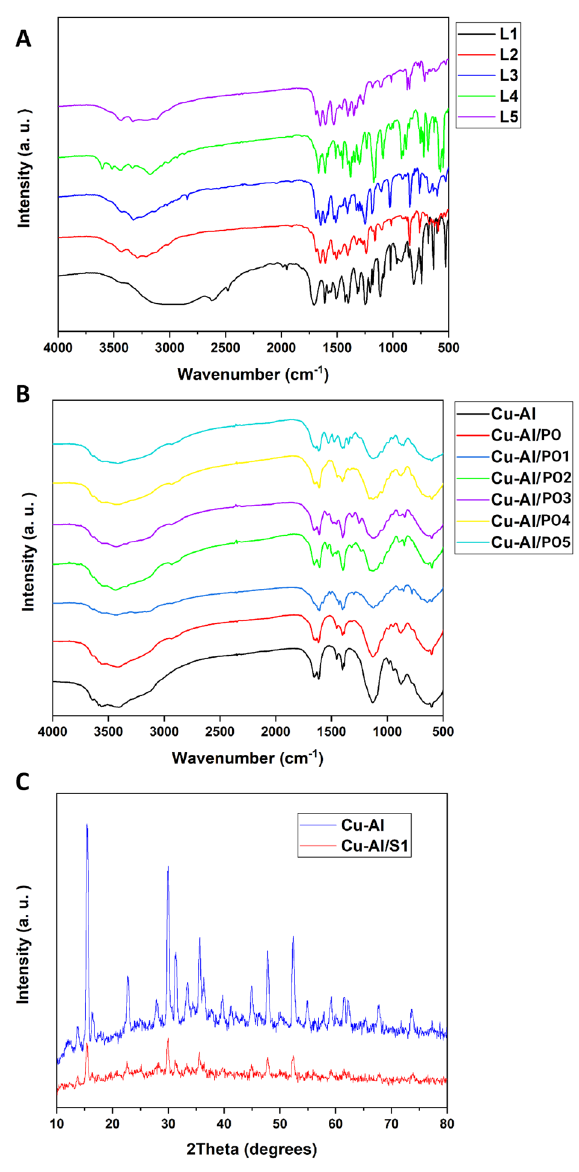
Figure 1. FTIR spectra of the synthesized nanomaterials ( A,B ). XRD results of the synthesized nanomaterials ( C ). S1 in part ( C ) stands for one of the